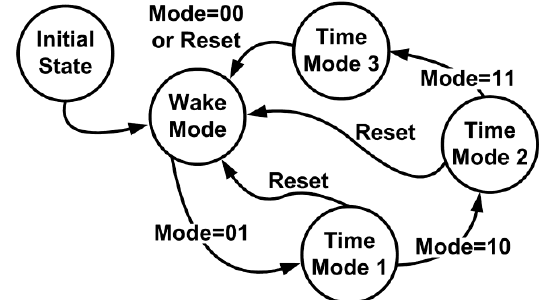
Figure 9. State diagram of the mode